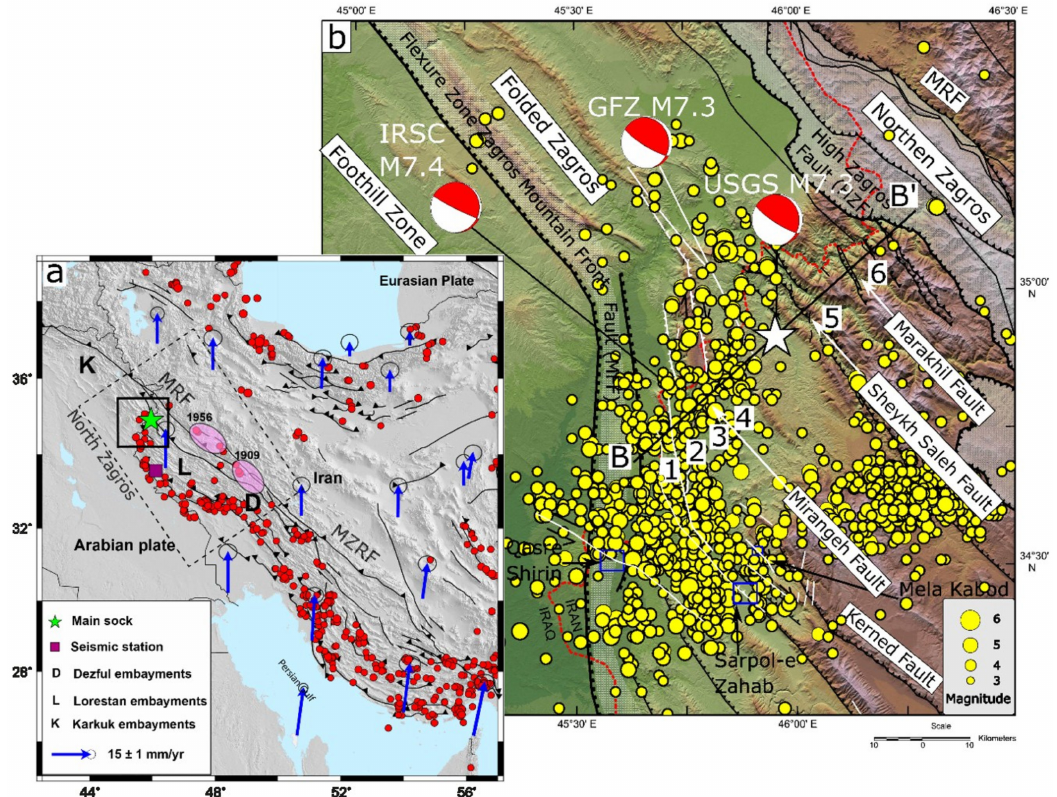
Figure 1. ( a ) The tectonic settings of Iran. Red dots are earthquakes (M w > 4.5) from the Global Centroid-Moment-Tensor (CMT) catalog (1976–2018), and blue arrows are GPS velocities relative to stable Eurasia from Vernant et al. (2004) [11]. The location of the study area shown in ( b ) is marked with a solid open rectangle. Two purple ellipses outline the location of the 1909 Silakhur and 1956 Sahneh earthquakes. MRF—Main Recent Fault; MZRF—Main Zagros Reverse Fault. ( b ) Shaded relief map of the study area. The beach balls show the location and focal mechanisms of the M w 7.3, 12 November 2017 earthquake from various sources. The white star represents the location of the main shock suggested by the U.S. Geological Survey (USGS). The white lines are faults and lineaments extracted from a detailed geological interpretation based on DEM and Sentinel-2 optical data, as well as discontinuity observed in the interferometric synthetic aperture radar (InSAR) measurements. Line BB’ is the seismic profile of this region (Figure 6 in Reference [24]). Numbers 1–6 represent the surface expression of geological structures along line BB’. Yellow circles show the location of aftershocks (M w > 2.5) provided by the Iranian Seismological Center (IRSC) during the 80 days after the main